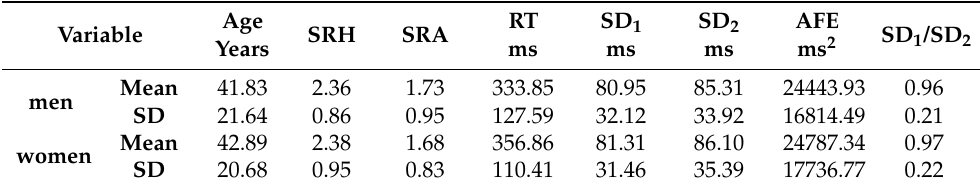
Table 2. Statistic indicators for investigated parameters in the subgroups of men ( n = 64) and women ( n = 56).